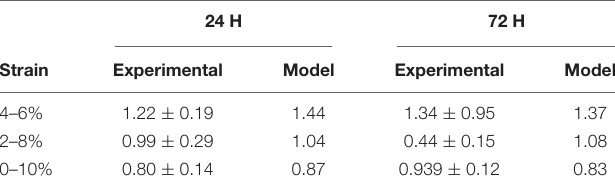
TABLE 4 | Fold change for cells at 24 and 72 h when seeded on PDMS and subject to different levels of cyclic strain (Mathieu et al., 2020).